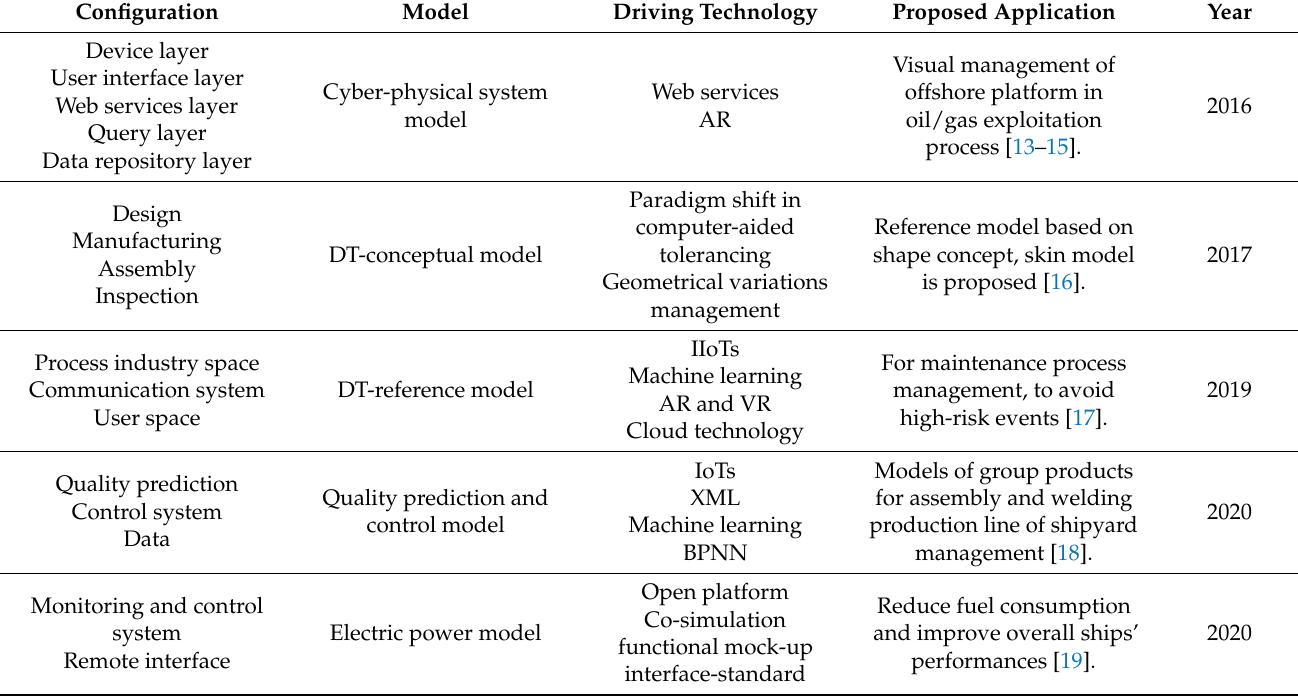
Table 1. Configuration, model and platform of DT applications for process